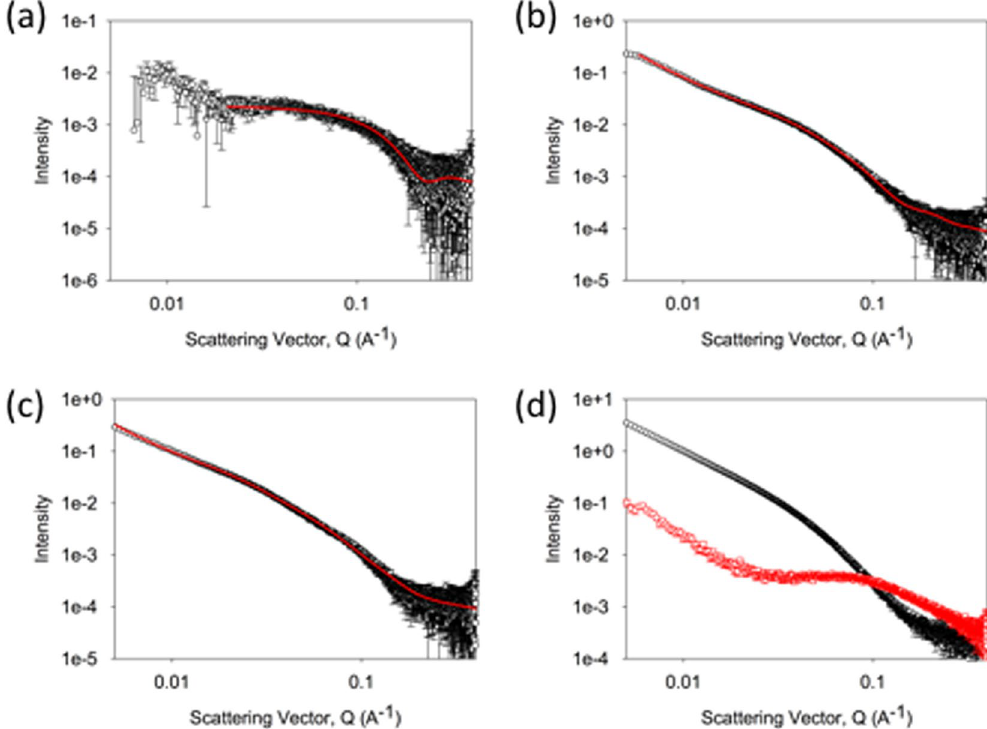
Figure 4. SAXS data and fitting. The scattering is shown for ( a ) a solution of 1 ; ( b ) a gel of 1 ; ( c ) a gel of 3 ; In all cases, the data are shown in black and the fits are shown in red. (d) shows an overlay of the scattering from a solution of 1 + 3 immediately after adding GdL (red) and after 800 minutes (black). Further SAXS data is available in the Supporting